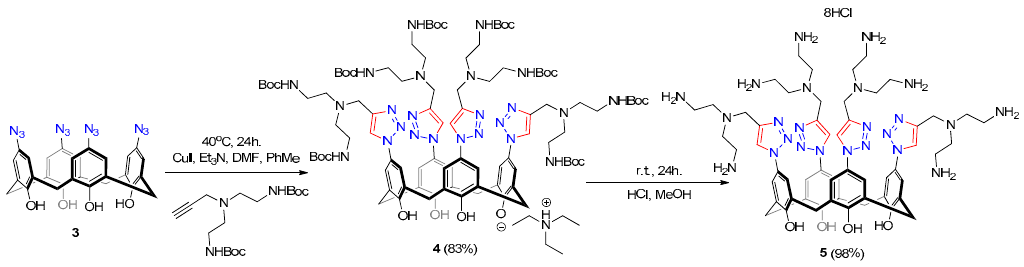
Figure 2. Crystal packing of 3 view along c axes.